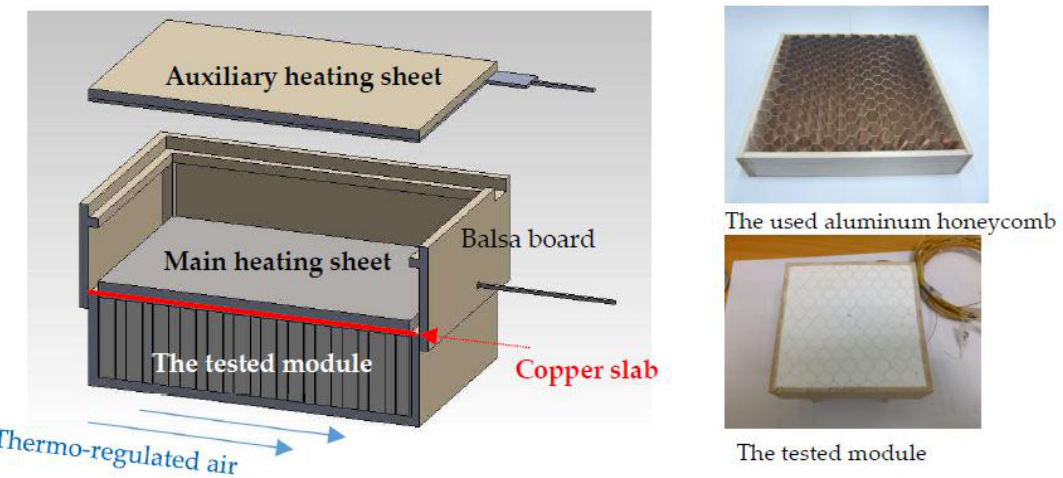
Figure 1. Test cell experimental setup ( left ) and the tested mPCM roof module ( right ).